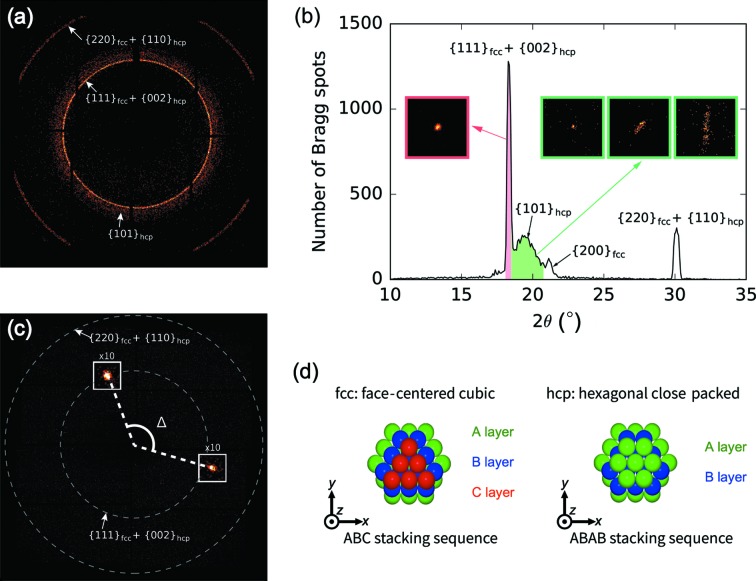
Distribution of the Bragg spot positions on the detector (a) and as a function of 2θ (b). Three sharp peaks are observed at 2θ ≃ 18.3, 21.1 and 30.1°. These peak positions correspond to {111}fcc + {002}hcp, {200}fcc and {220}fcc + {110}hcp, respectively. In addition, one broad peak is observed at 2θ ≃ 19.4°, which corresponds to the {101}hcp position. Note that the yield of the {220}fcc + {110}hcp peak is undervalued because of the limit on the detection region. The angular correlations were calculated using spots lying on the {111}fcc + {002}hcp peak (18.1° < 2θ < 18.5°, filled with pink) and the {101}hcp peak (18.5° < 2θ < 20.7°, filled with green). Insets show the images of the Bragg spots located on the {111}fcc + {002}hcp and {101}hcp peaks. (c) A representative single-shot image used for the angular-correlation analysis. The image contains two Bragg spots on the {111}fcc + {002}hcp and {101}hcp rings. The areas marked by white rectangles are zoomed in (×10). (d) F.c.c. and h.c.p. stacking sequences.